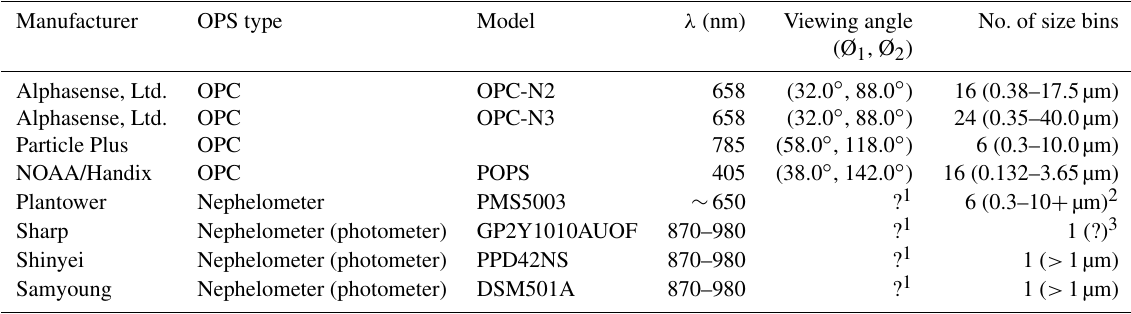
Table 1. Characteristics of a selection of commercially available low-cost optical particle counters and nephelometers.